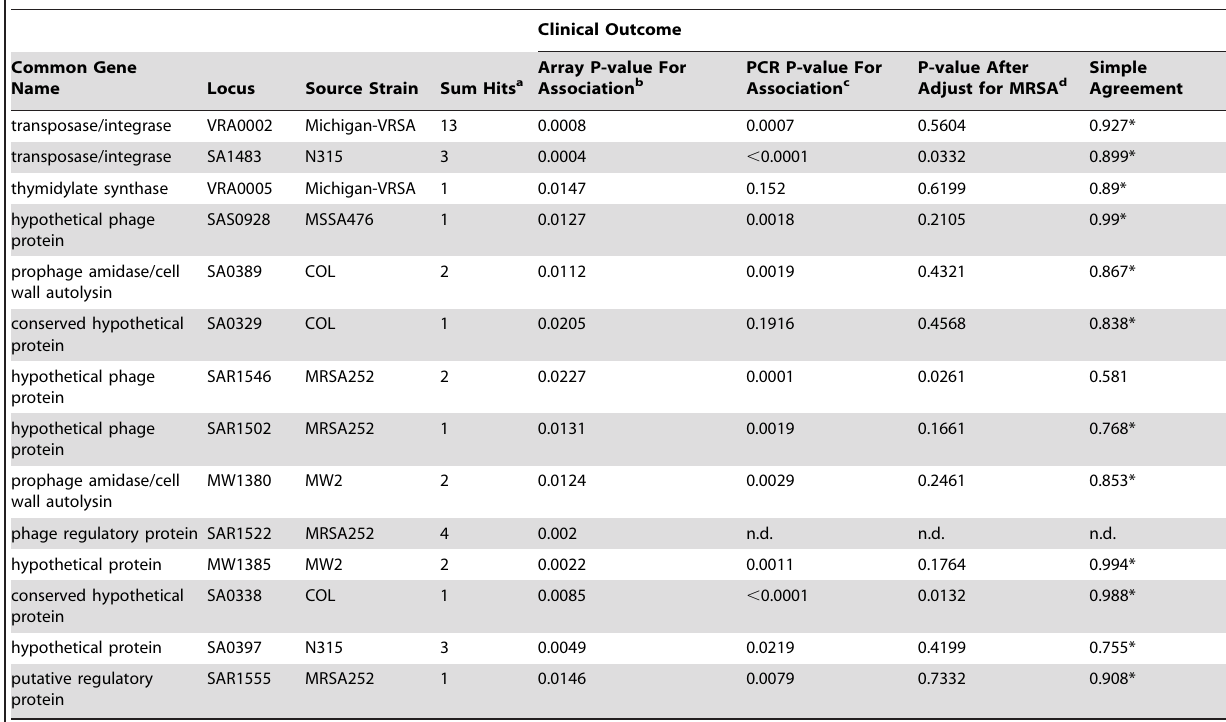
Table 2. Putative virulence genes associated with complicated infections.